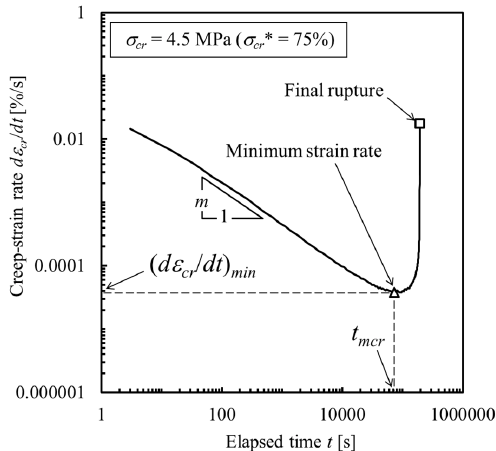
Figure 7. Creep-strain rate ( d ε cr / dt ) versus elapsed time t [22,24,26,27].